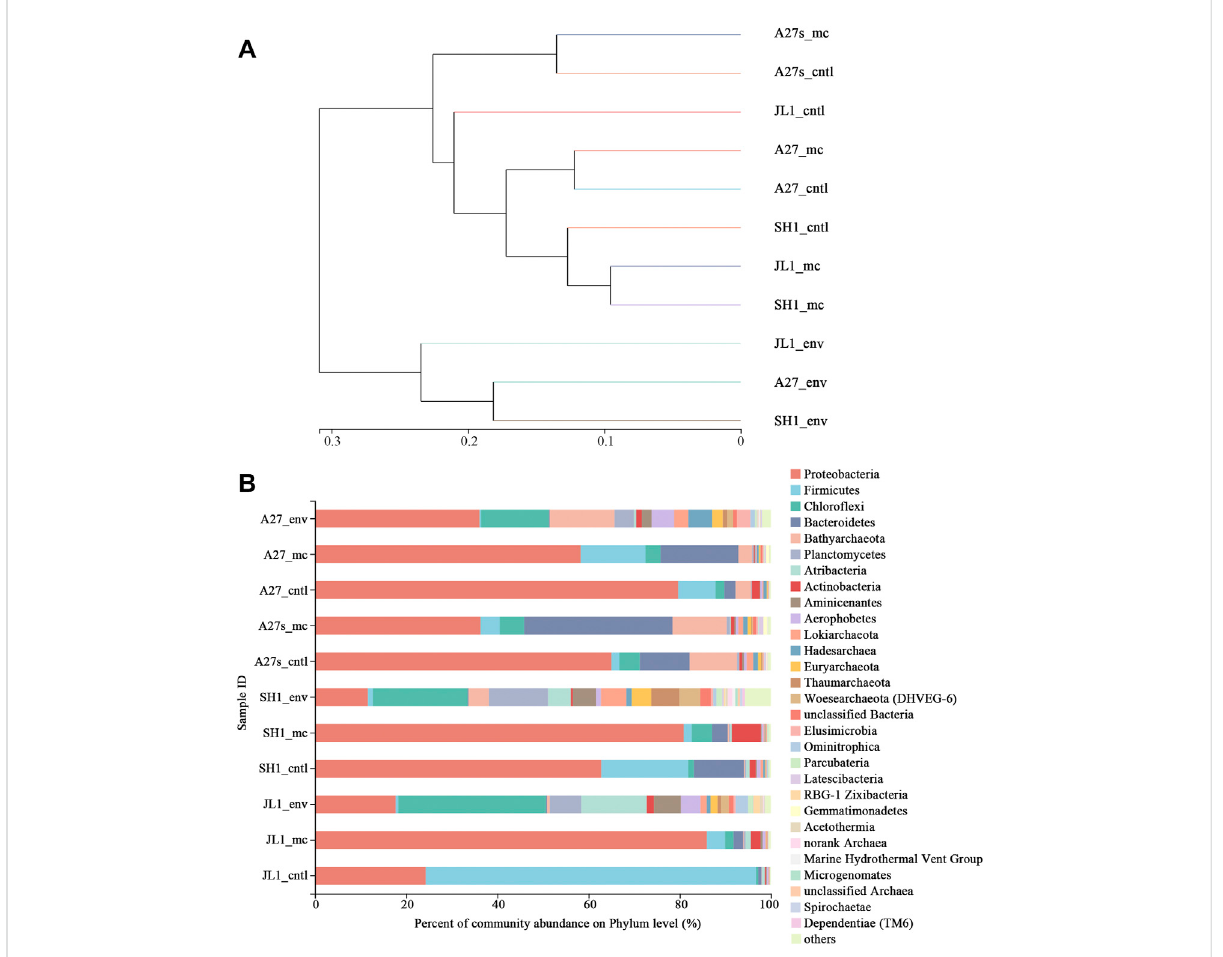
FIGURE 5 Comparisonofmicrobialcommunitiesamongallsamples. (A) HierarchicalclusteranalysisusingpairwiseweightedUniFracdistances.Thescale bar between branches represents the distance between samples. (B) Community abundance of microorganisms at the phylum level for environmental sediment samples (sampling site_env) and the related incubation slurry samples amended with 13 CH 4 (sampling site_mc) and N 2 (sampling site_cntl). Taxa with abundances < 0.5% were included in “ others ”